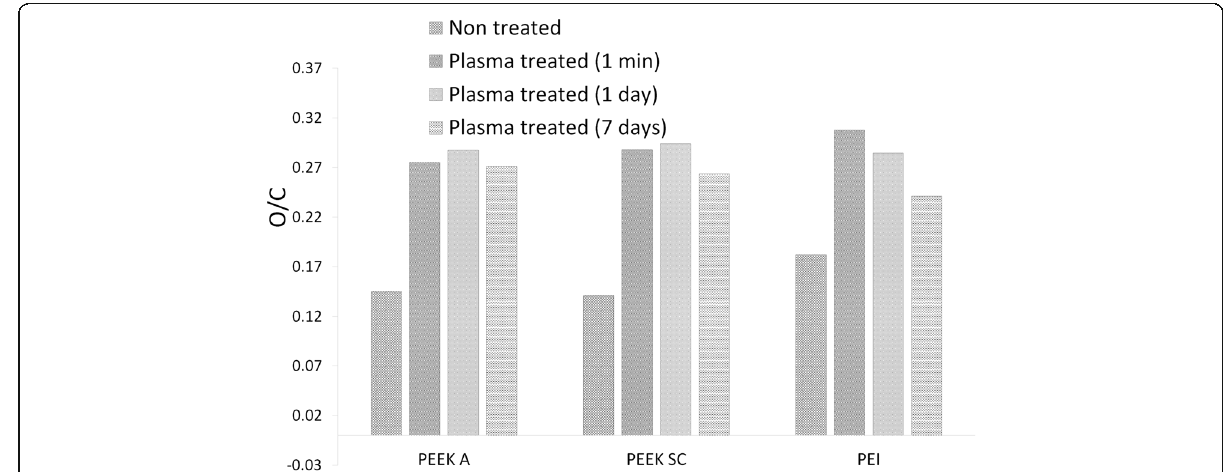
Fig. 10 Investigation of the O/C by